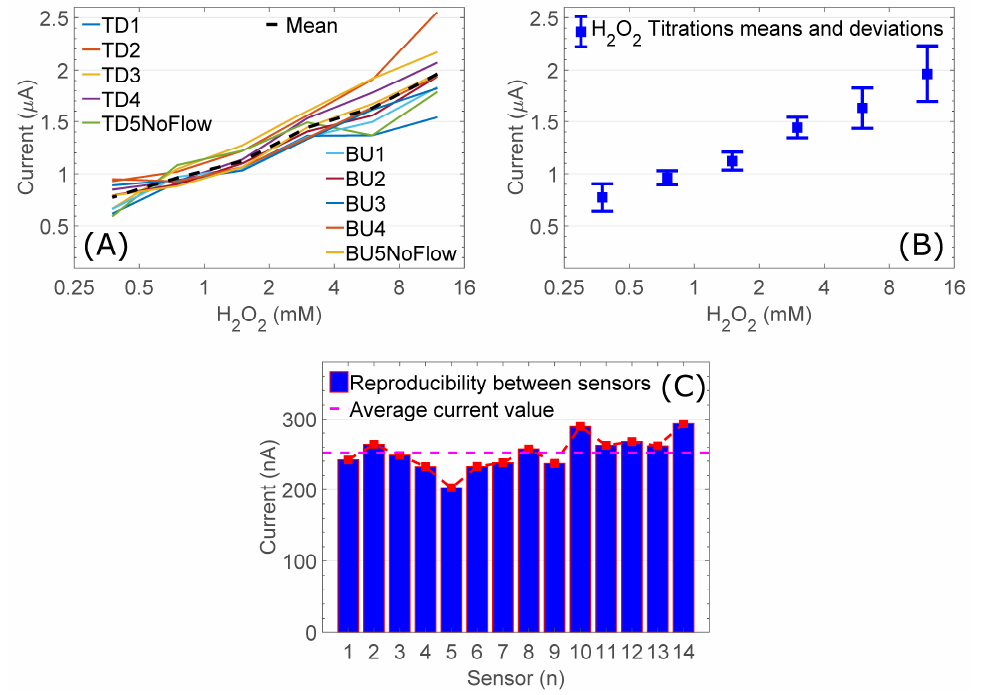
Figure 2. ( A , B ) Reproducibility within sensor. Ten H 2 O 2 titrations were assessed independently on a single sensor to establish the reproducibility of the electrochemical measurement